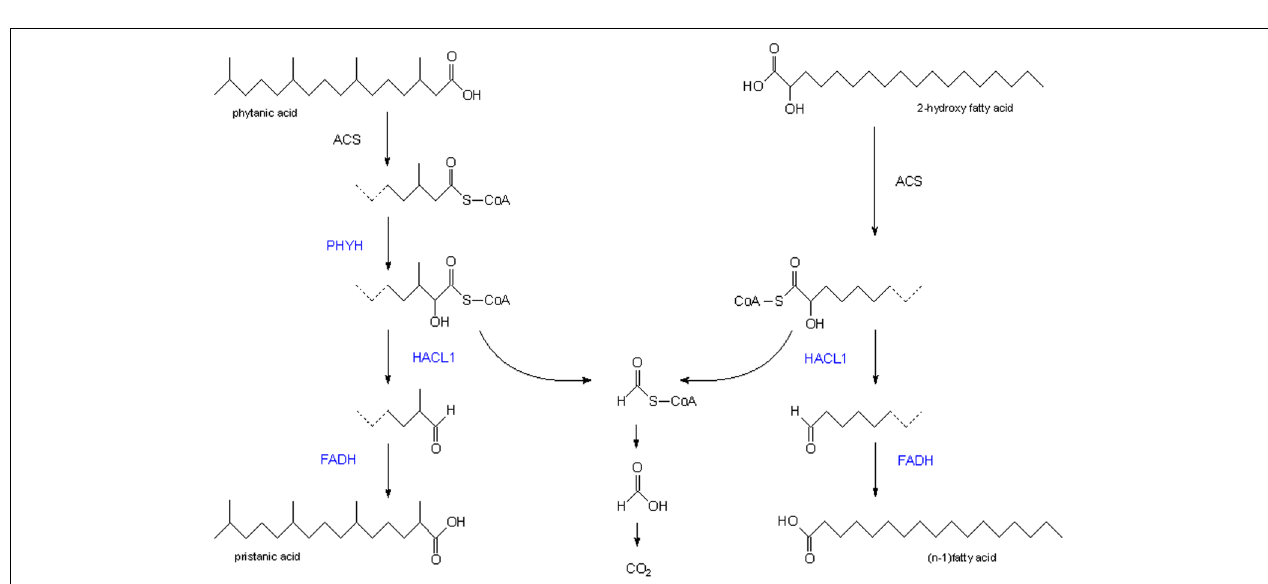
can act on straight chain substrates, shown at the left , as well. The latter compounds are also recognized by more selective enzymes which do not tolerate a 2-methylbranch. ACAA1, 3-ketoacyl-CoA thiolase; ACOX, acyl-CoA oxidase; AMACR, 2-methylacyl-CoA racemase; MFP, multifunctional protein; SCPx, sterol carrier protein X-thiolase.